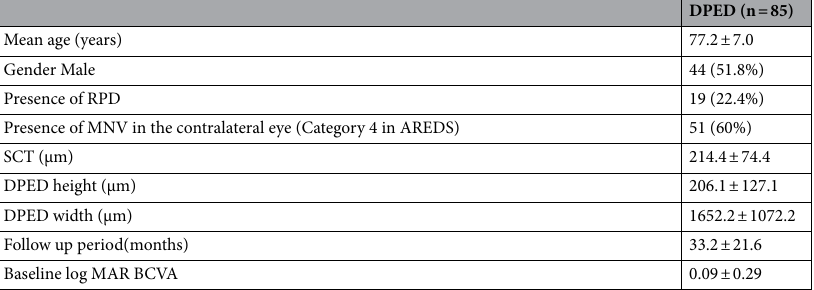
Table 1. Baseline demographic characteristics of patients with drusenoid pigment epithelial detachment. RPD: reticular pseudodrusen, MNV: macular neovascularization, SCT: subfoveal choroidal thickness, DPED: drusenoid pigment epithelial detachment, log MAR: logarithm minimum angle of resolution, BCVA: best- corrected visual